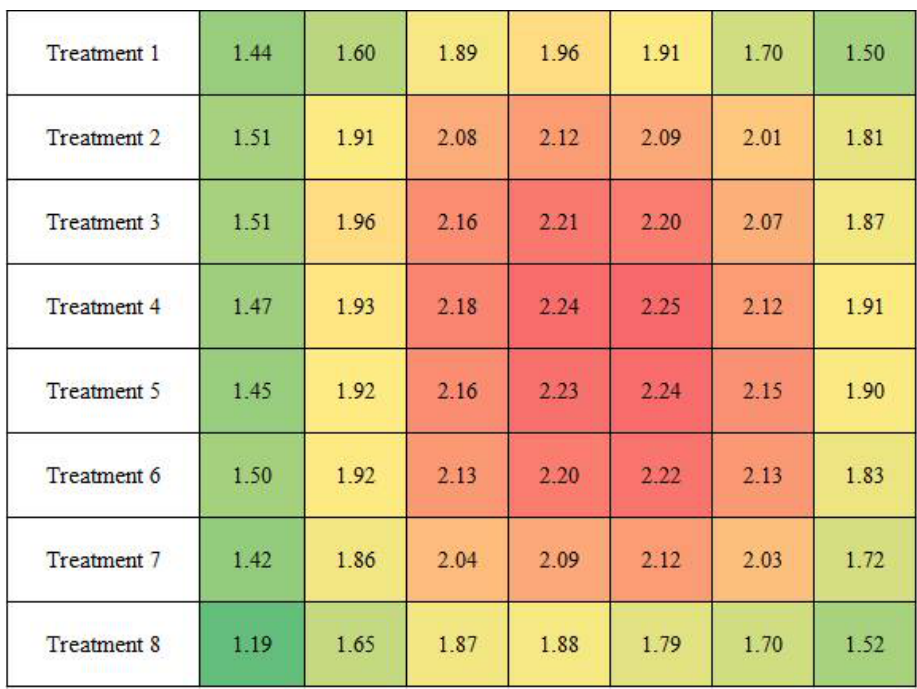
Figure A7. Map of UV light intensity (irradiance) measurements for UV-A (365 nm, fluorescent) for Treatment 1 to Treatment 8. The color gradient green–yellow–red represents increasing UV light intensity. Units: mW/cm 2 .